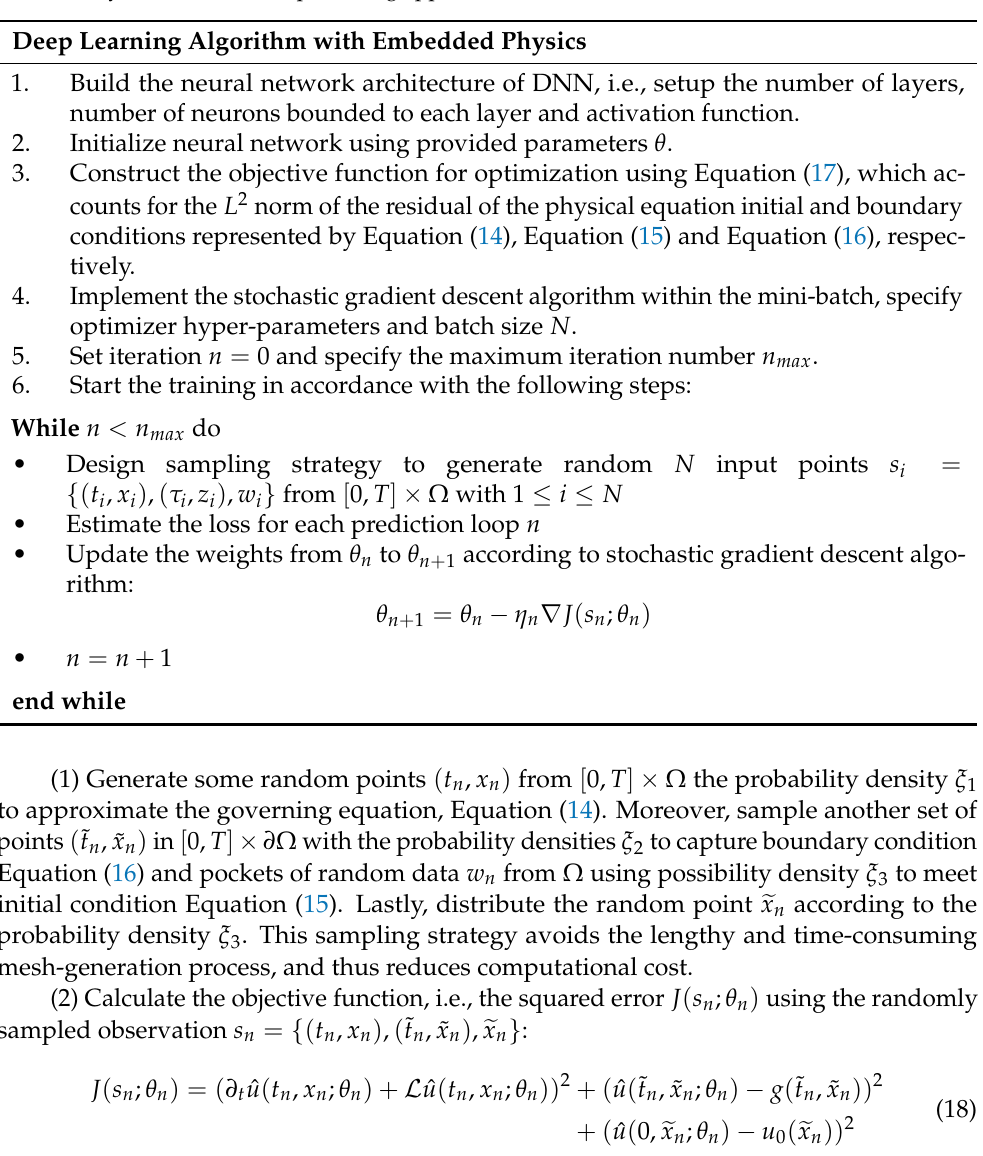
Table 1. Physics-informed deep learning